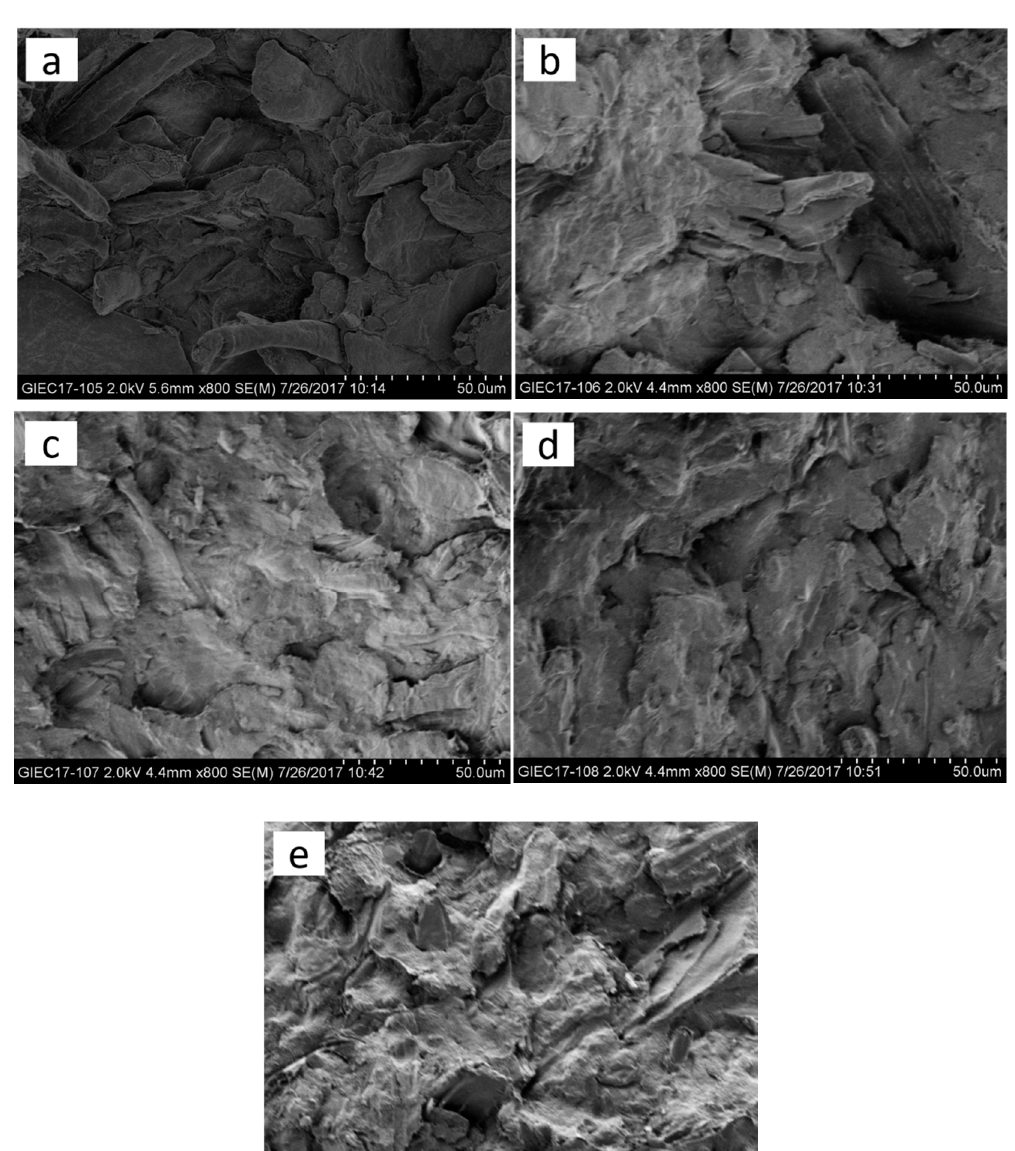
MAPE Content (%) Figure 7. Impacts of maleic anhydride-grafted polyethylene (MAPE) content on mechanical properties and water resistance of ONP–HDPE composites. 3.4. Interfacial Characterization of ONP/HDPE Composites The interfacial adhesion of ONP and HDPE could be inferred from the fracture surface microstructure of ONP/HDPE composite. SEM images of fracture surfaces of the composites reinforced with 50% fibers which were treated with 4% ( v / w ) MTCS are shown in Figure 8. A composite prepared without MAPE showed identifiable ONP fibers as well as gaps around them, which indicated that the interfacial adhesion between modified fibers and the matrix was weak. The reason was thought to be that the polarity difference between the modified ONP fibers and HDPE